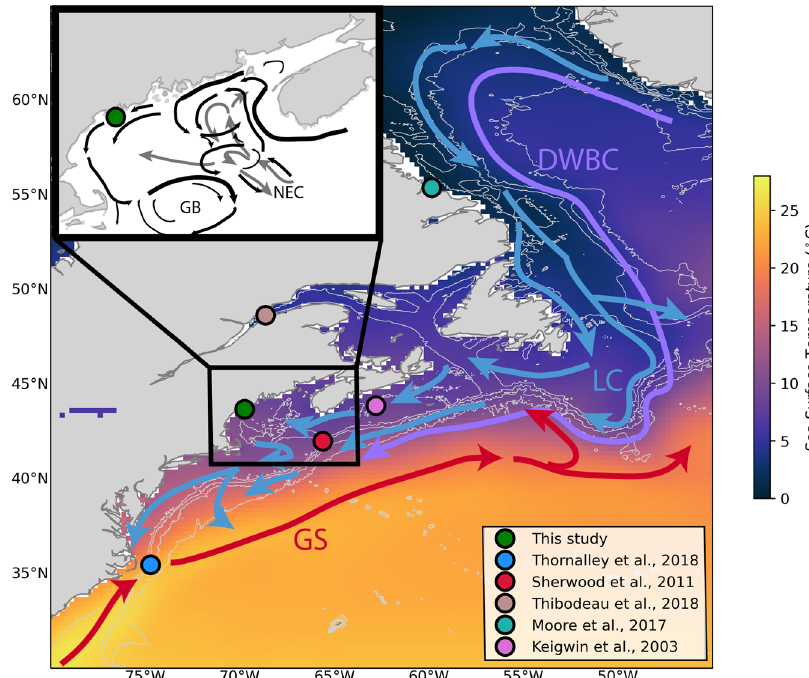
Fig. 1 Map of study site and broader North Atlantic region. Arrows indicate schematic depictions of major ocean currents while colors indicate average sea surface temperatures. Markers indicate the location of the study site as well as other paleoceanographic records mentioned in the manuscript (see map legend). The site of the Boothbay Harbor sea surface temperature (SST) instrumental record is indistinguishable from the site of this study (green marker) on this map. Bathymetry contours are marked in white at 200, 1200, 2200, and 3200 m depths from Smith and Sandwell 88 . SSTs are from the World Ocean Atlas 2018 climatological mean (from 1981 to 2010) 89 . The black box in the main fi gure shows the Gulf of Maine region highlighted in more detail in the inset. Black arrows in the inset depict surface currents, with gray arrows showing sub-surface currents. LC Labrador Current, DWBC Deep Western Boundary Current, GS Gulf Stream, NEC Northeast Channel, GB Georges